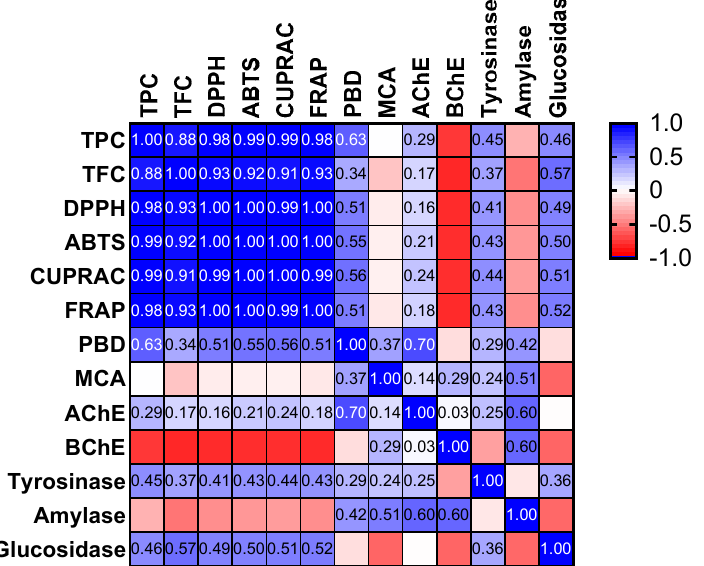
Figure 2. Pearson’s correlation values (R) in the biological activity assays performed; AChE, acetyl- cholinesterase; BChE, butyrylcholinesterase; CUPRAC, cupric ion reducing antioxidant capacity; DPPH, 1,1-diphenyl-2-picrylhydrazyl; FRAP, ferric ion reducing antioxidant power; MCA, metal chelating activity; PBD, phosphomolybdenum assay; TFC, total flavonoid content; TPC, total phe- nolic content.